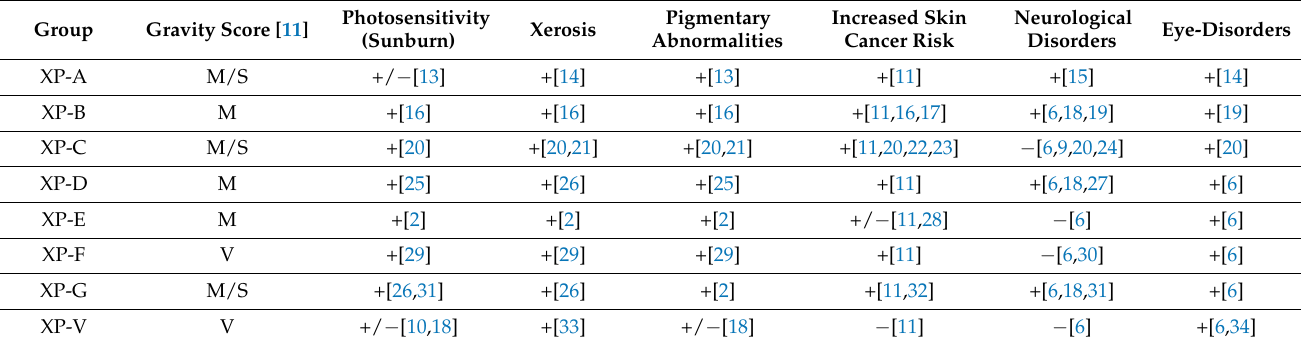
Table 2. Clinical signs of Xeroderma Pigmentosum based on complementation groups. (M) mild; (S) severe; (+) symptomatic manifestation; ( − ) absence of